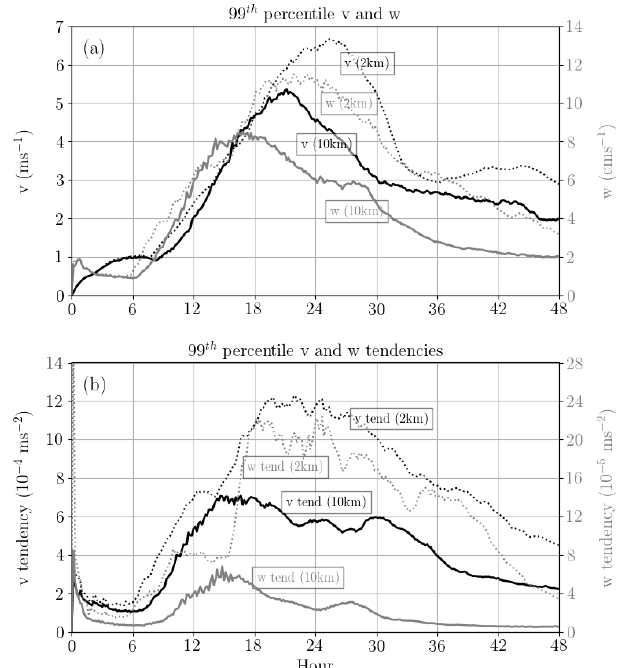
Figure 2. Evolutions of the 99 percentiles of (a) horizontal velocity, v (black; axis on the left), and vertical velocity, w (gray; axis on the right) in the simulation of slantwise convection. Panel (b) is the same as (a) but for their tendencies (black and gray lines for v and w tendencies, respectively). Solid lines are for the 10km simulation, while the dotted ones are for the 2km